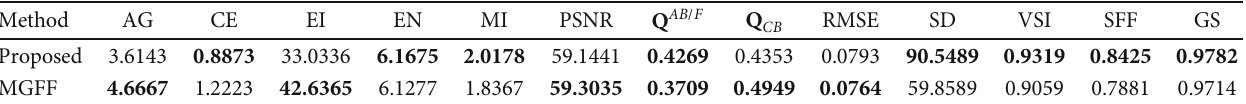
Figure 8: Example source images with Gaussian white noise and stray light noise. Table 5: Average evaluation metric values of the MGFF method and the proposed method on Gaussian white noise of the SDD dataset. The best values of each metric are marked as bold.